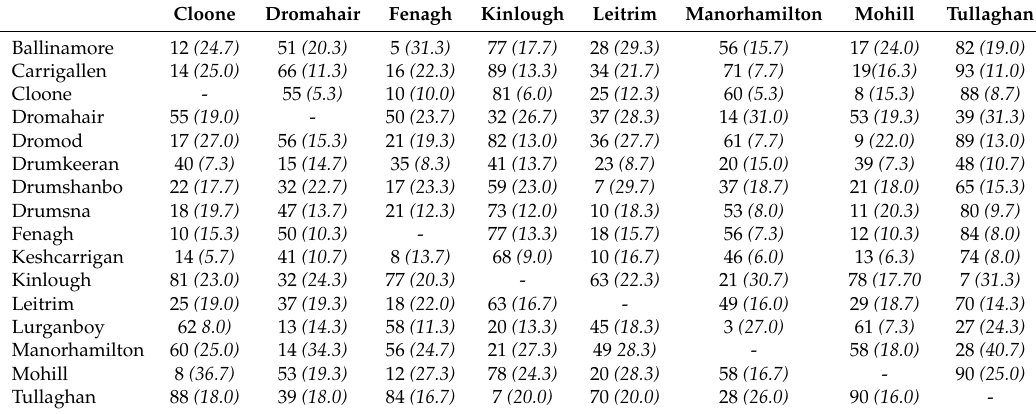
Table 14. Approximate distances between each town in km and the percent of runs that lead to an outbreak. Cloone